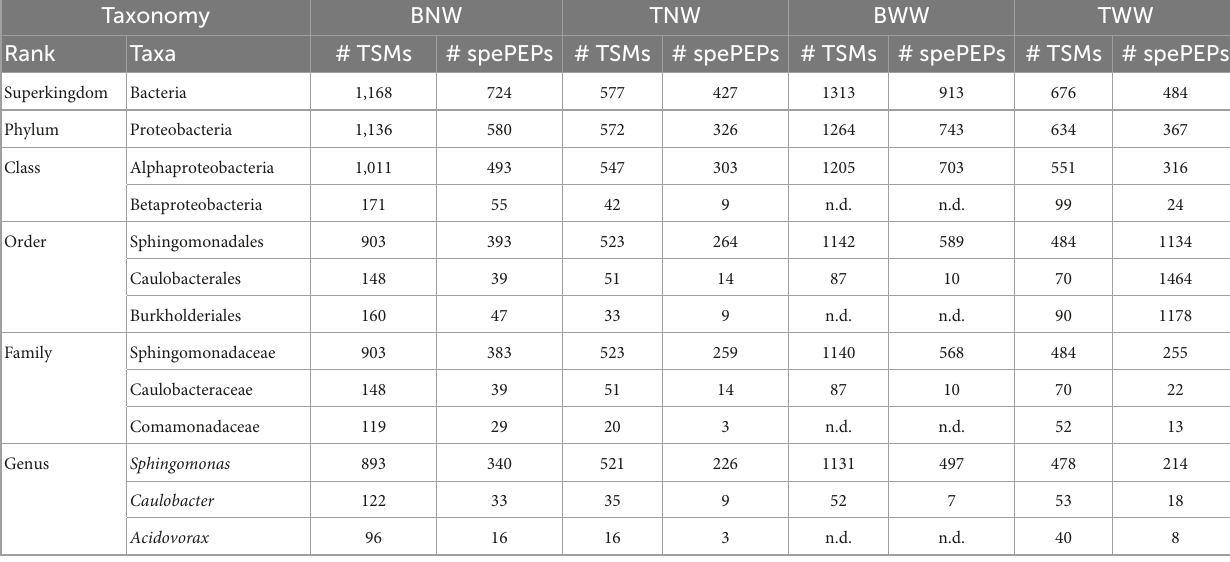
TABLE 2 Number of taxa-to-spectrum matches (TSMs) and taxon-specific peptides (spePEPs) detected at the different taxonomical ranks in the four biofilms*.